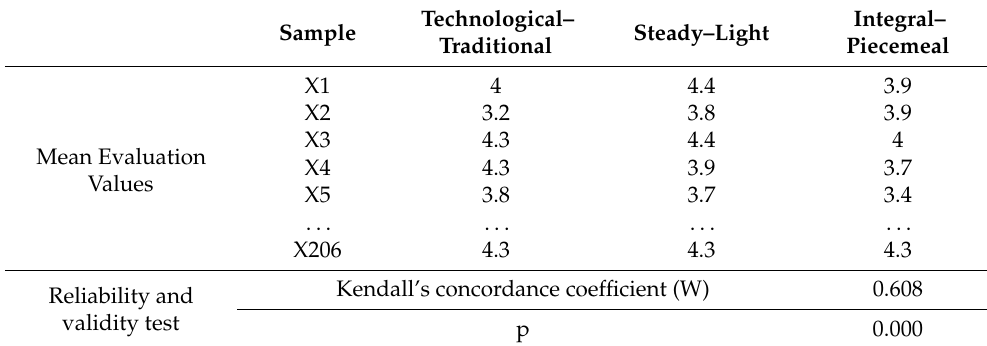
Table 2. The result and analysis of the first experiment.